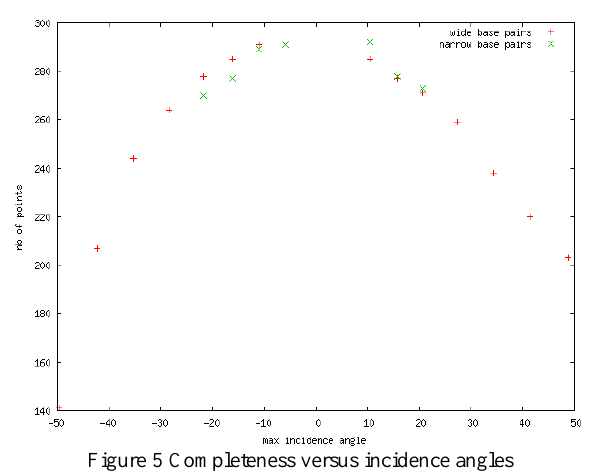
Figure 5 Completeness versus incidence angles